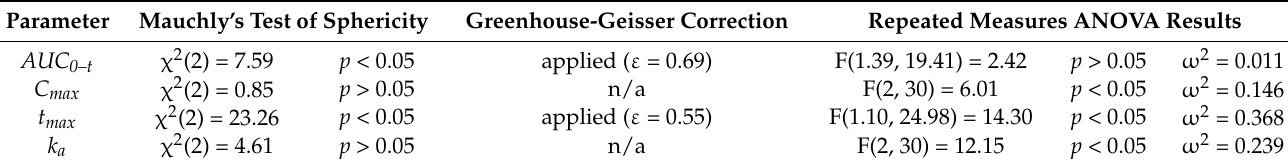
Table A5. Detailed repeated measures ANOVA results (comparisons within cross-over design study). Parameter Mauchly’s Test of Sphericity Greenhouse-Geisser Correction Repeated Measures ANOVA